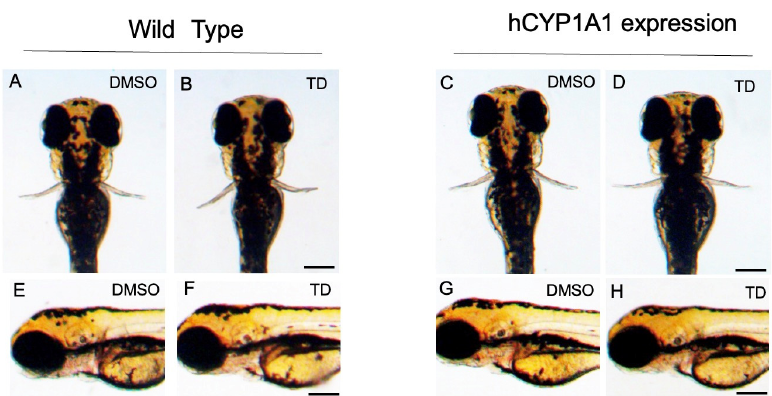
Figure 4. Effects of thalidomide on hCYP1A1-expressing zebrafish during development. Em- bryos/larvae of wild-type (WT) zebrafish and hCYP1A1-expressing zebrafish (hCYP1A1-zebrafish) were exposed to 200 µM thalidomide (TD) or 0.02% DMSO as a vehicle from 17 hpf to 72 hpf. ( A , B , E , F ): wild-type zebrafish. ( C , D , G , H ): hCYP1A1-zebrafish. Zebrafish in ( A , E , C , G ) were exposed to DMSO. Zebrafish in ( B , F , D , H ) were exposed to thalidomide. ( A – D ): dorsal views; ( E – H ): lateral views. Scale bars = 200 µm.